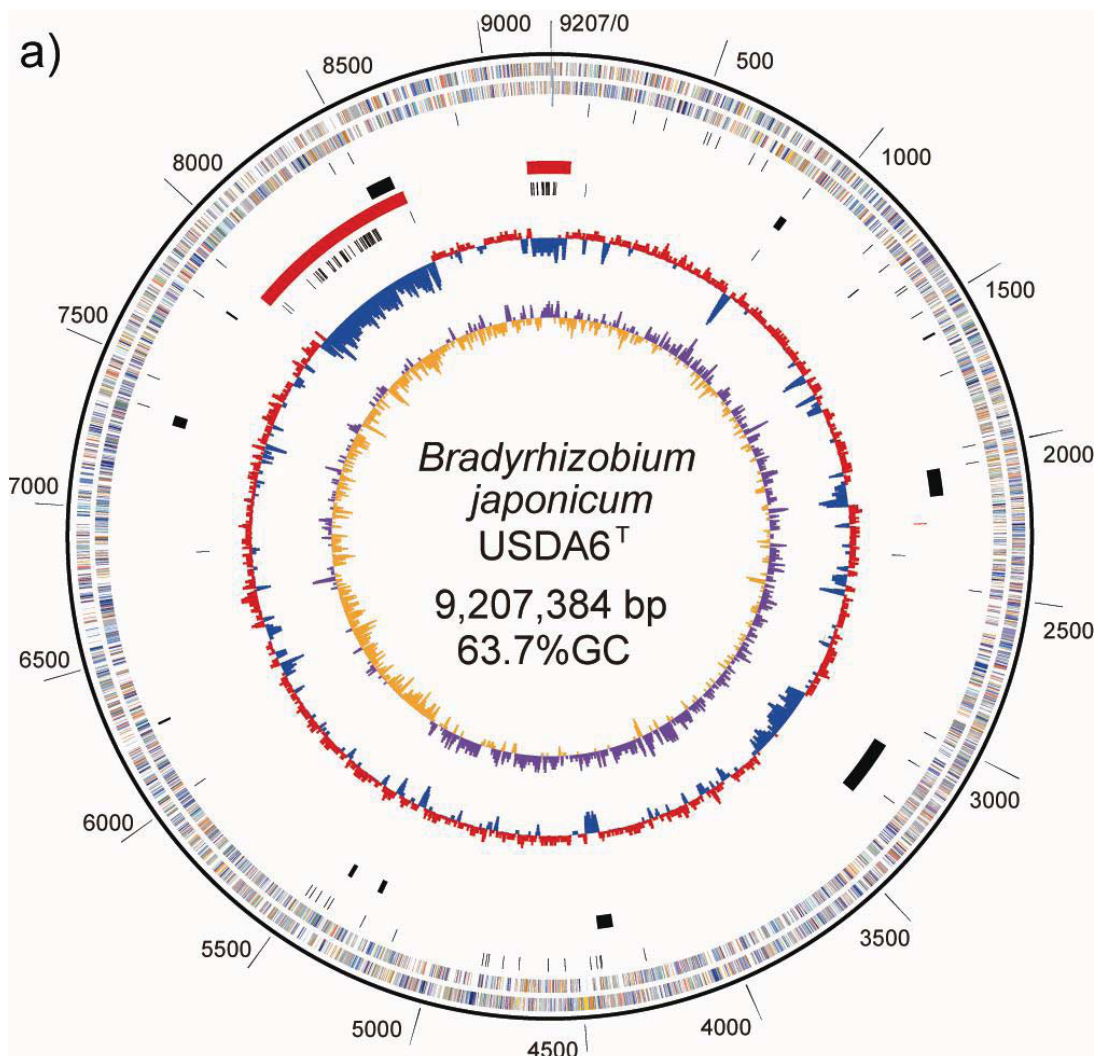
Figure 1. Schematic representations of circular replicons in B. japonicum strains. ( a ) USDA6 T chromosome and ( b ) USDA110. The scale towards the outside of each map indicates genomic location (in kb). The bars in the outermost circle and the second circle show the positions of the putative protein-encoding genes in clockwise and counter-clockwise directions, respectively. The putative genes are represented by 18 colors, based on Clusters of Orthologous Groups (COG) assignments, as described in Supplemental Figure 1. The third circle from the outside indicates positions of structural RNA genes. In the fourth circle, the black bars indicate areas of putative genomic islands inserted in a tRNA gene. Three red bars within the fifth circle represent regions corresponding to the possible symbiosis island. The sixth circle shows the distribution of insertion sequences (ISs), as black bars. The innermost and second circles from the center show the GC skew values (yellow and purple) and the average GC percentage (blue and red), respectively, calculated using a window-size of 10 kb. This map was depicted using the GenomeViz